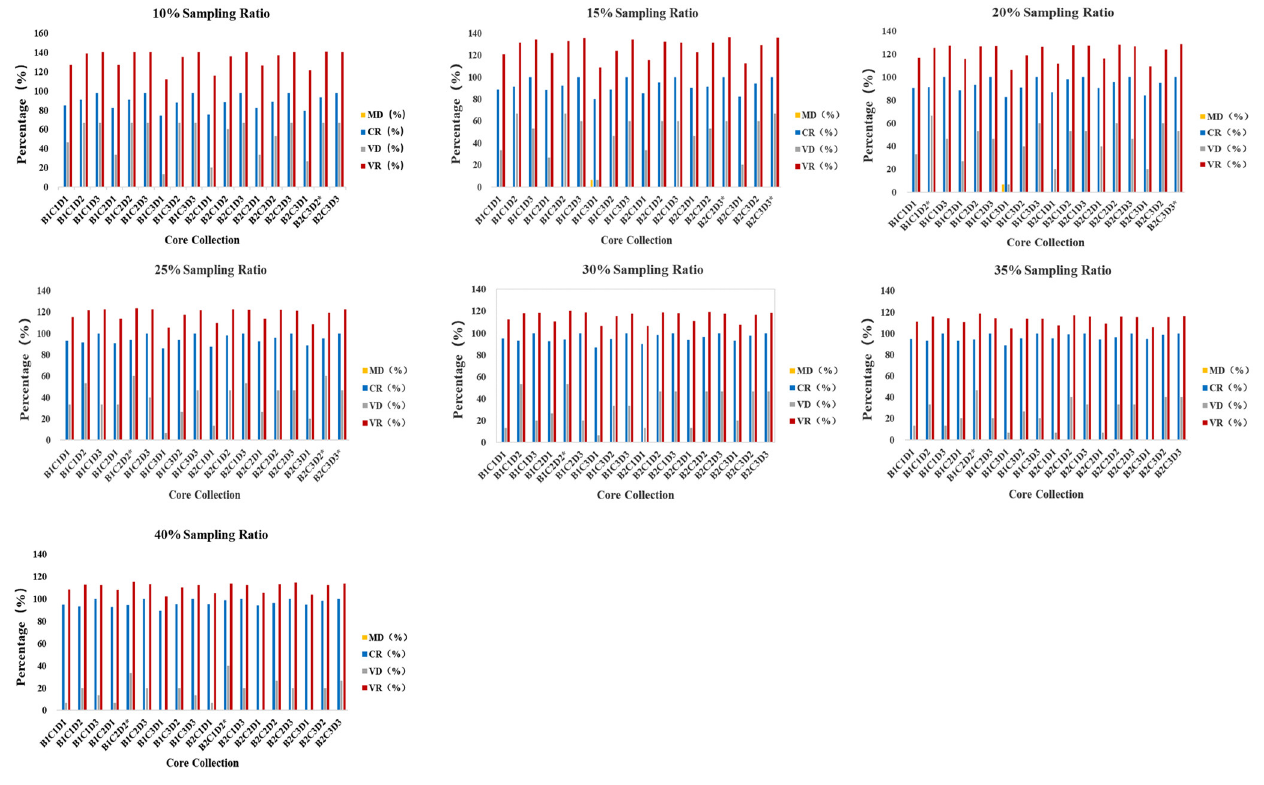
Figure 6. Percentage of trait differences between the core collections and the initial collection obtained by different combinations. B1 and B2 represent Euclidean distance and Mahalanobis distance, respectively; C1, C2, and C3 represent the unweighted pair-group average method, Ward’s method, and mediate distance method in the systematic clustering, respectively. D1, D2, and D3 represent the random sampling, deviation sampling, and preferred sampling methods, respectively. Seven sampling ratios of 10%, 15%, 20%, 25%, 30%, 35%, and 40% were set. The percentage of the mean difference (MD), percentage of the variance difference (VD), coincidence rate of the range (CR) and rate of variation in the coefficient of variation (VR). * represents the maximum for each sampling ratio in the figure. Table 5. Percentage of trait differences between the core and original collection under different sam- pling strategies. Sampling Ratio